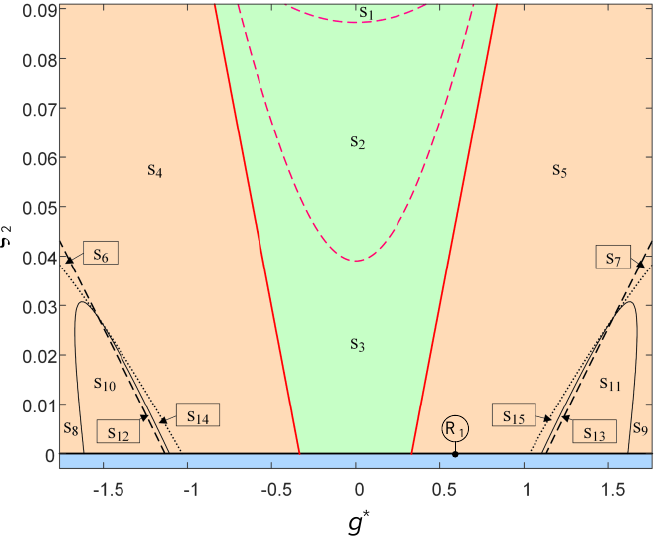
Figure 3. Time-delay independent stability: Time-delay independent stability region; Time-delay dependent stability region; Unstable region.